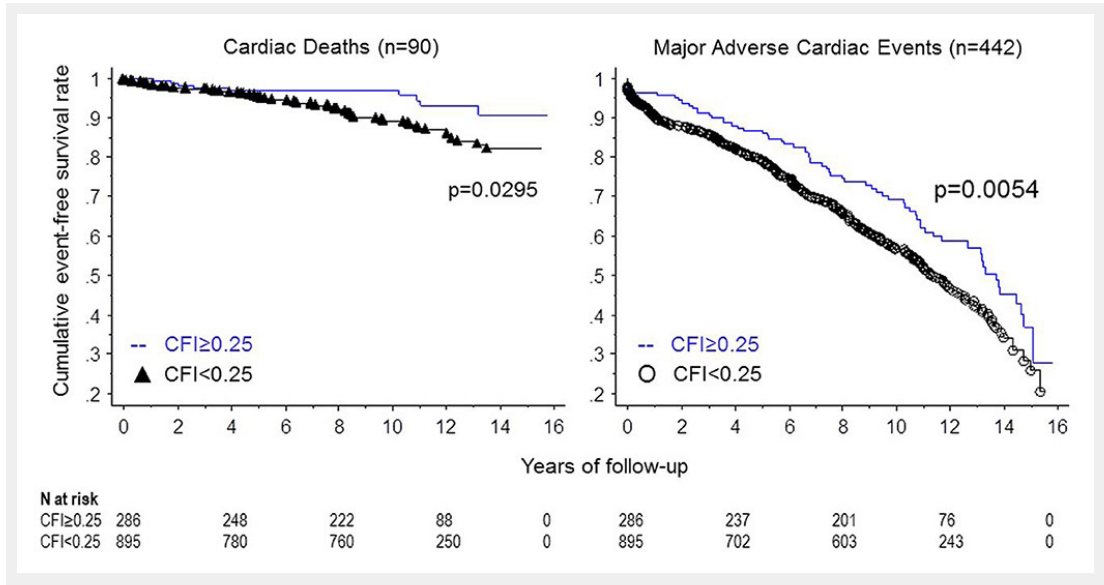
Figure 9 Cumulative survival rates related to cardiac mortality (left panel) and to major adverse cardiac events (right panel) in patients with low and with high collateral flow index (CFI). (Data from Seiler C, et al. Prognostic relevance of coronary collateral function: confounded or causal relationship? Heart. 2013;99(19):1408-14 [5], with permission from BMJ Publication Group